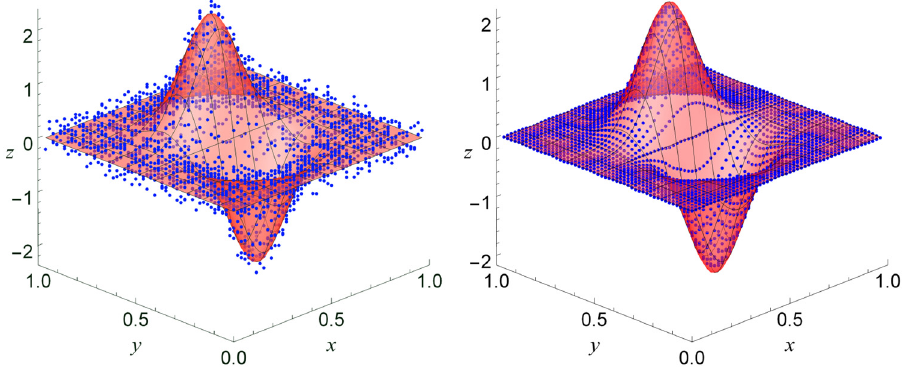
Figure 2: True data surface along with the noisy data ( left ) and smoothed data ( right ) for Example